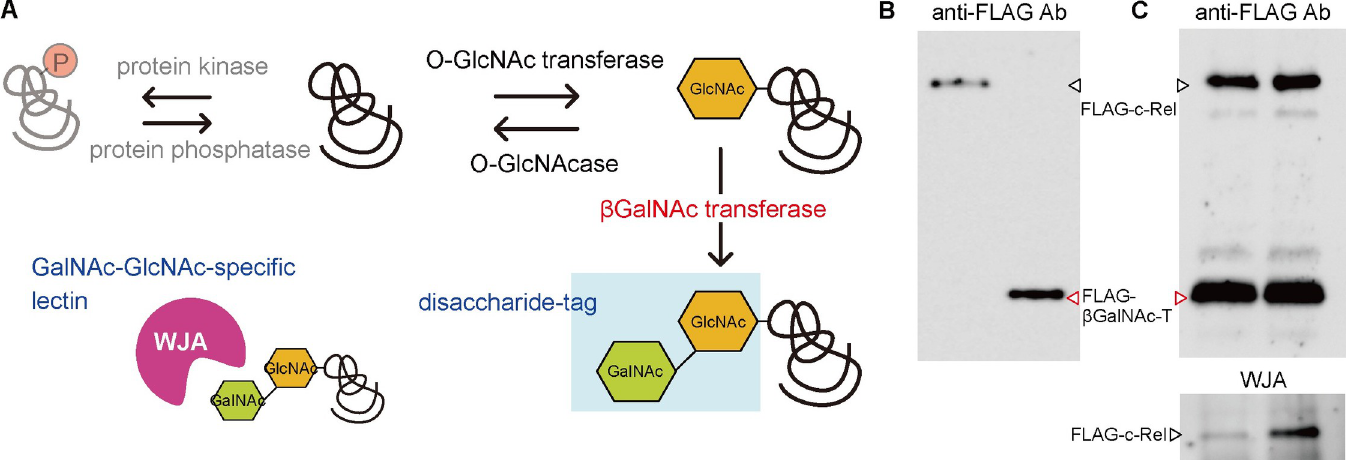
Fig 2. Schematic illustration of disaccharide-tag method to detect O-GlcNAcylated proteins. (A) Schematic illustration of disaccharide-tag method. (B) Western blotting of purified FLAG-c-Rel and FLAG- β GalNAc-T using anti-FLAG antibody. (C) Purified FLAG-c-Rel and FLAG- β GalNAc-T were mixed and incubated at 25˚C for 12 h in the absence (left lane) or presence (right lane) of UDP-GalNAc. Amount of each protein was confirmed by Western blotting using anti-FLAG antibody and extension of O-GlcNAc residue was confirmed by Western blotting using